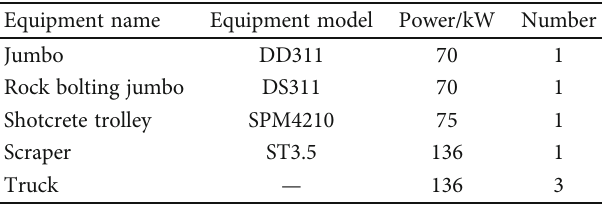
Table 4: Personnel and ore extraction parameters.